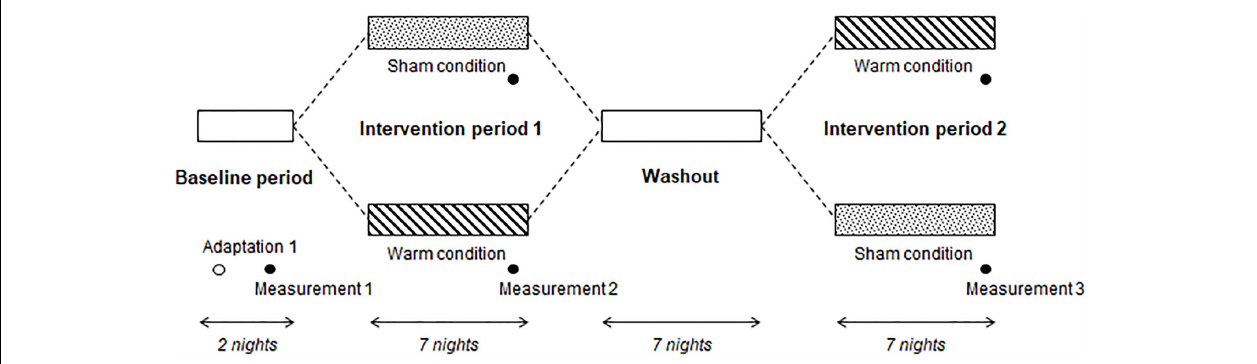
FIGURE 2 | Experimental protocol. Participants maintained their habitual sleep-wake schedule during the Baseline period. During Intervention period 1, participants were allocated to the sham condition (wore a sham eye mask before their usual bedtime) or warm condition (wore a warming eye mask before their usual bedtime). After the Washout, participants wore the other eye mask (i.e., that they had not worn during Intervention period 1) during Intervention period 2. In the Baseline period, electroencephalography, skin temperature, and electrocardiography were measured for 2 consecutive nights. The same measurements were performed at the end of Intervention periods 1 and